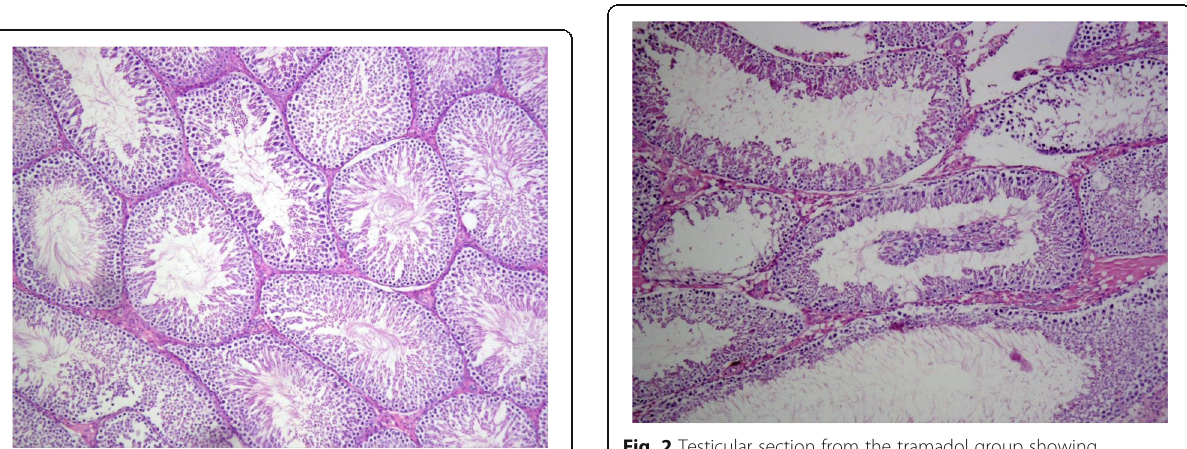
Fig. 2 Testicular section from the tramadol group showing disorganized spermatogenesis with focal exfoliation of desquamated germinal cells in the lumen of seminiferous tubules (H & E, ×